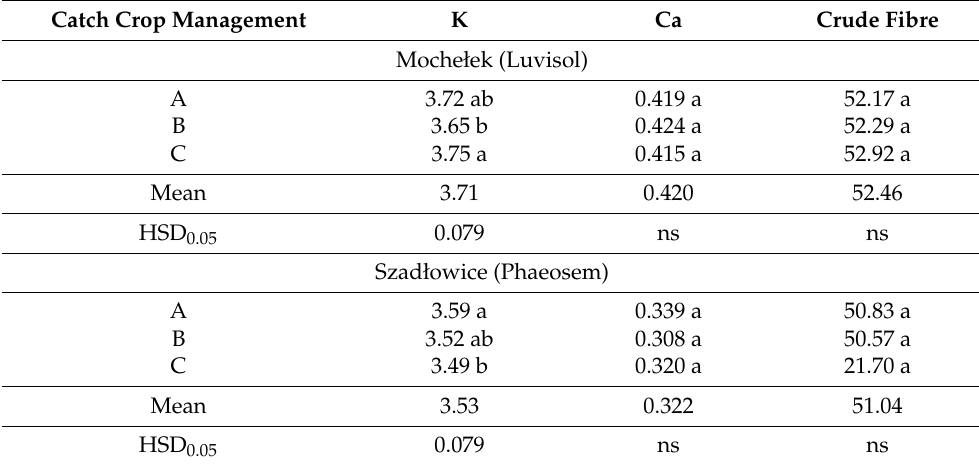
Table 9. Content of potassium (K), calcium (Ca) and crude fiber in spring barley grain (g kg − 1 ) depending on a catch crop—means for 2009 to 2011.